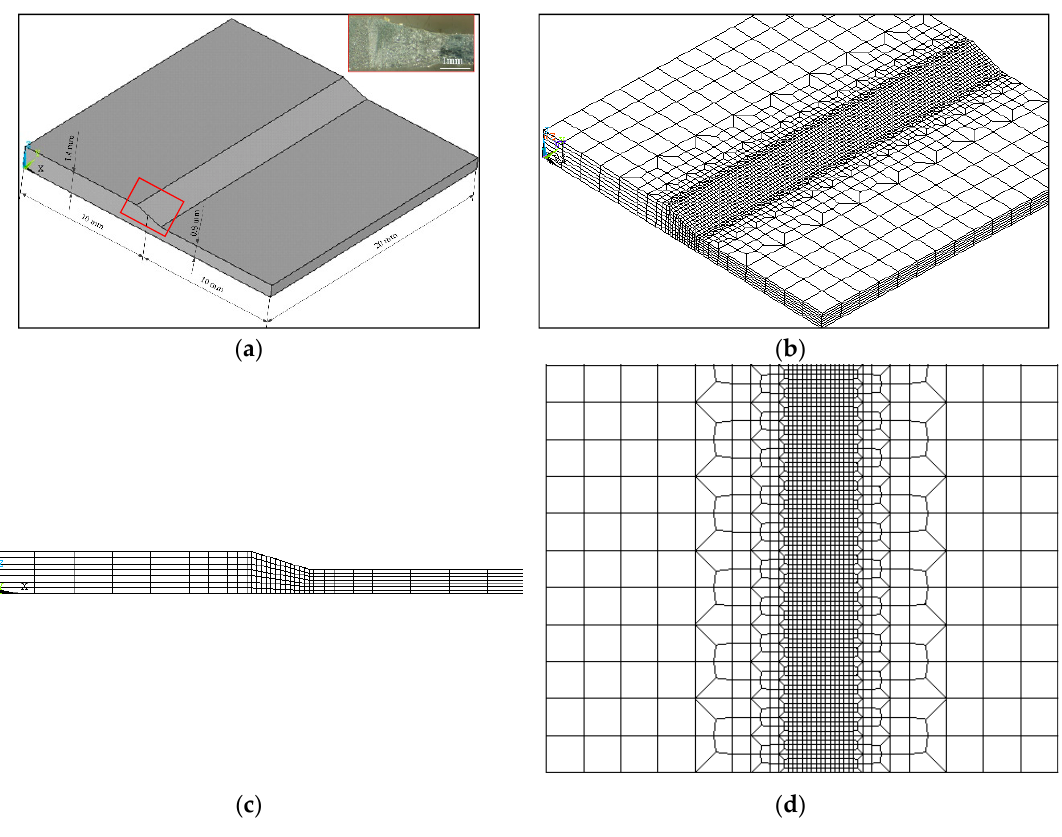
Figure 5. ( a ) Geometric model; ( b ) overall schematic diagram of mesh; ( c ) mesh of X-Z plane; ( d ) mesh of X-Y plane.